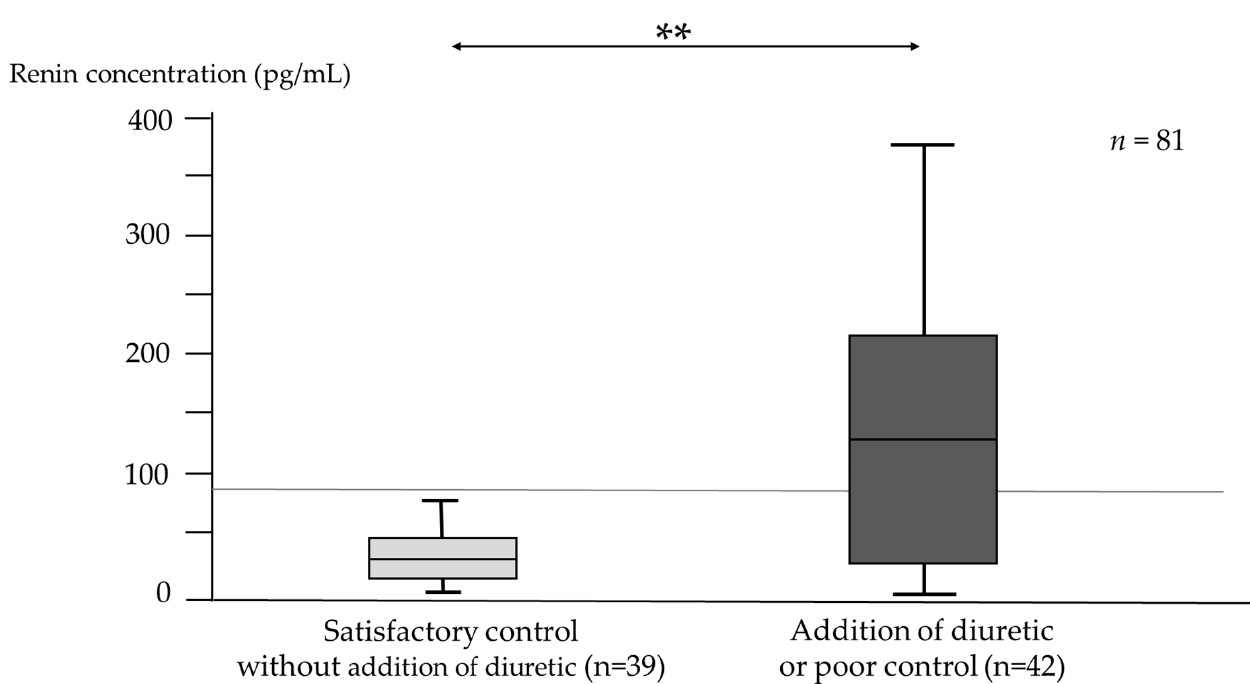
Figure 8. Relationship between control of refractory ascites 3 months after RFX administration and serum renin concentration before RFX administration ( n = 81). p -values were determined using the Mann–Whitney’s U test ( p < 0.01 **). n , number; RFX, rifaximin.